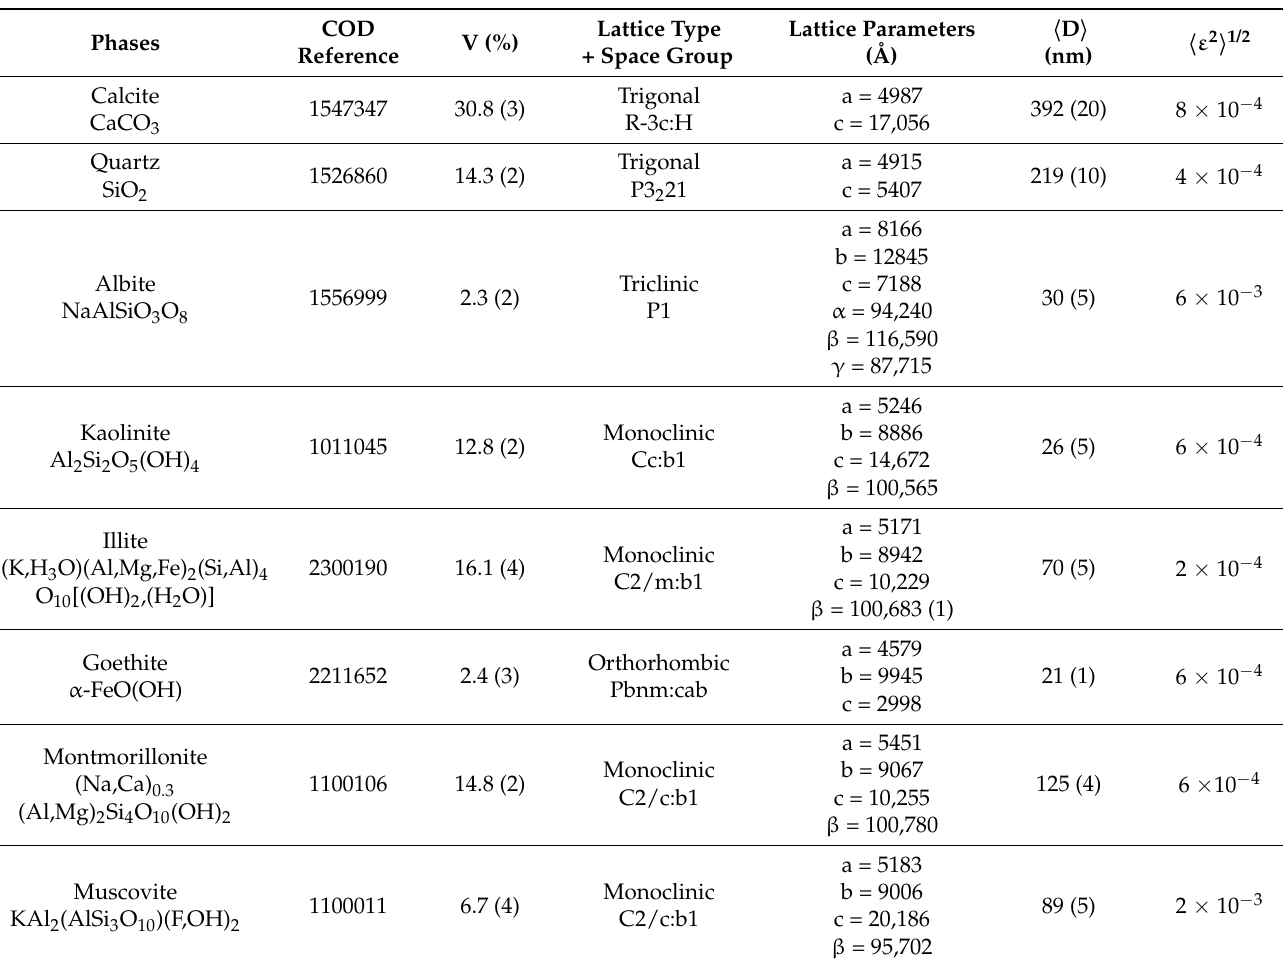
Figure 4. X-ray diffraction diagram of GWM. The calculated diagram (red color) is superimposed onto the experimental profile (black color). At the bottom, we present the difference curve (I exp –I calc ). Table 6. The Mineralogical Composition of GWM.